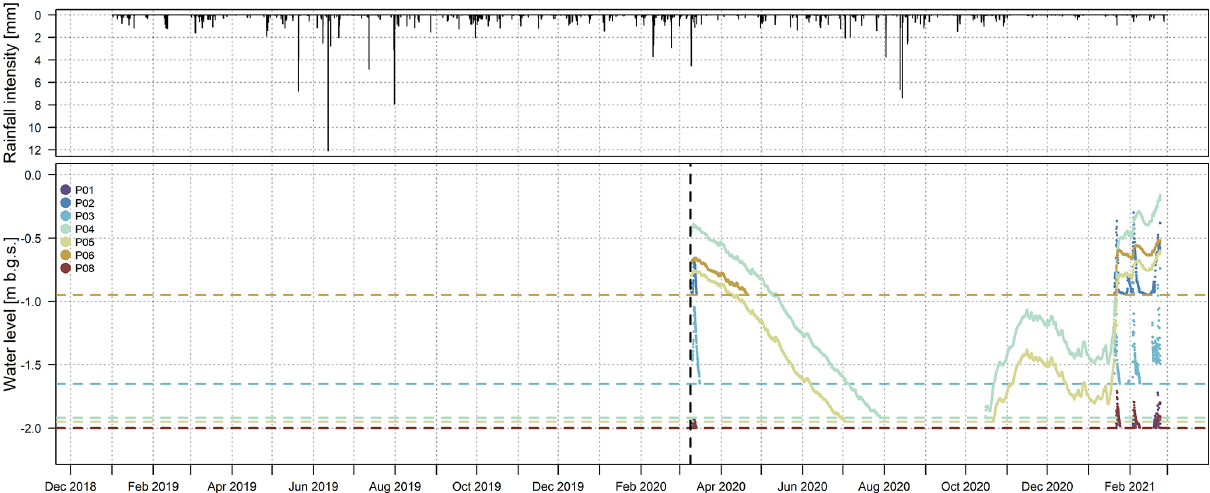
Figure 6. Time series of water level data. The plots were made using the data set as it appears in the online archive. The dashed vertical line indicates the start of the measurements (9 March 2020). The dashed horizontal lines indicate the depth of the wells. The data are plotted using a scientific colour scale from Crameri (2018) chosen according to the principles described in Crameri et al. (2020).